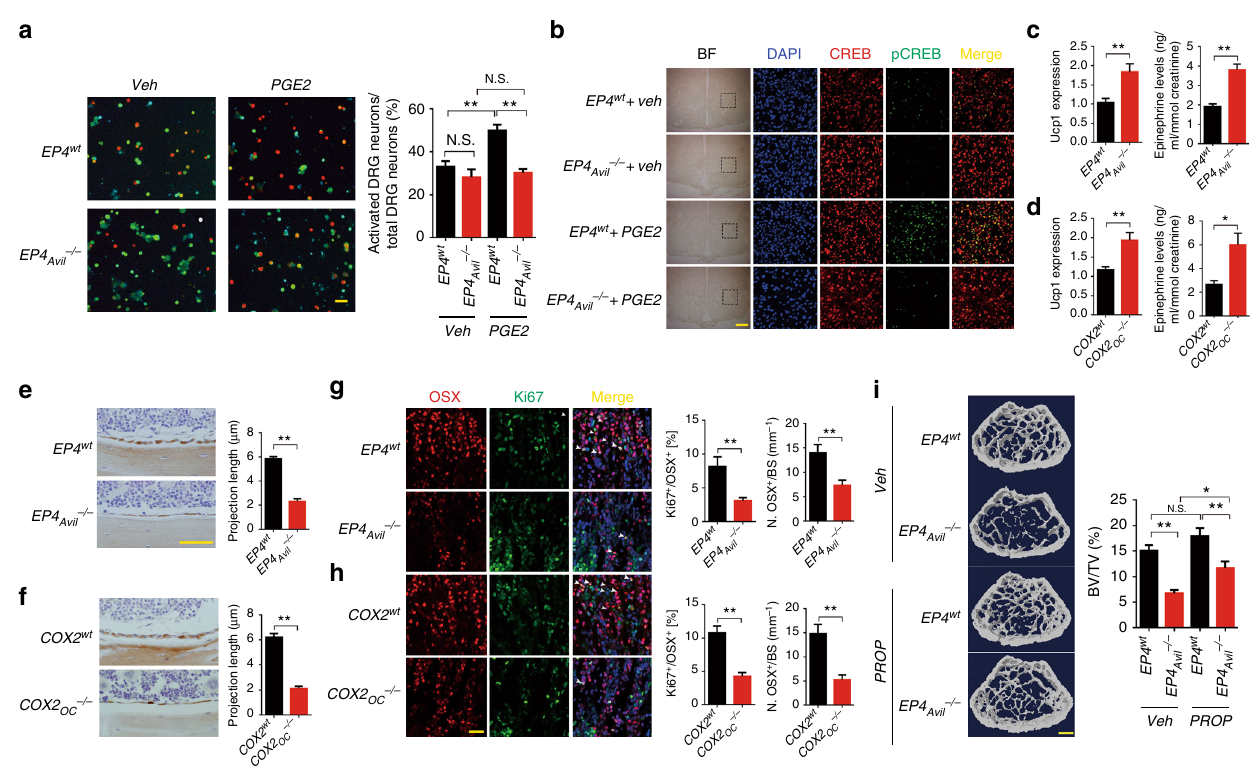
Fig. 6 PGE2 stimulates hypothalamic CREB signaling through sensory nerve. a Representative images of DRG neurons isolated from EP4 wt and EP4 Avil − / − mice pre-incubated with vehicle or 10 μ M PGE2 for 5 min, and subsequently treated with calcium imaging buffer (with calcium loaded). The red dots represent activated DRG neurons, and the green dots represent resting DRG neurons. Scale bar, 50 μ m. Quantitative analysis was performed with results from three independent assays. b Double-immuno fl uorescence images of hypothalamus tissue sections from 12-week-old EP4 wt or EP4 Avil − / − mice with vehicle or 3 mg per kg PGE2 treatment for 6 h using antibodies against CREB (red) and p-CREB (green). DAPI stains nuclei blue. Scale bar, 20 μ m. c qRT-PCR analysis of UCP1 expression in adipose tissue and ELISA evaluation of epinephrine level of the serum from EP4 wt and EP4 Avil − / − mice. d qRT- PCR analysis of UCP1 expression in adipose tissue and ELISA evaluation of epinephrine level of the serum from COX2 wt and COX2 OC − / − mice. e , f Representative images of immunostaining of the femoral bone tissue sections from EP4 wt and EP4 Avil − / − and COX2 wt and COX2 OC − / − mice with antibody against OCN. Scale bar, 50 μ m. Projection length of the OCN + lining cells was measured. g , h Double-immuno fl uorescence images of femoral bone tissue sections from 12-week-old COX2 wt and COX2 OC − / − and EP4 wt and EP4 Avil − / − mice using antibodies against OSX (red) and Ki67 (green). DAPI stains nuclei blue. Scale bar, 20 μ m. Percentage of Osx- and Ki67-double positive cells and the number of OSX positive cells per trabecular bone surface were quanti fi ed. i 8-week-old male EP4 wt and EP4 Avil − / − mice were injected with low dose (0.5 mg per kg per day) propranolol for 6 weeks.